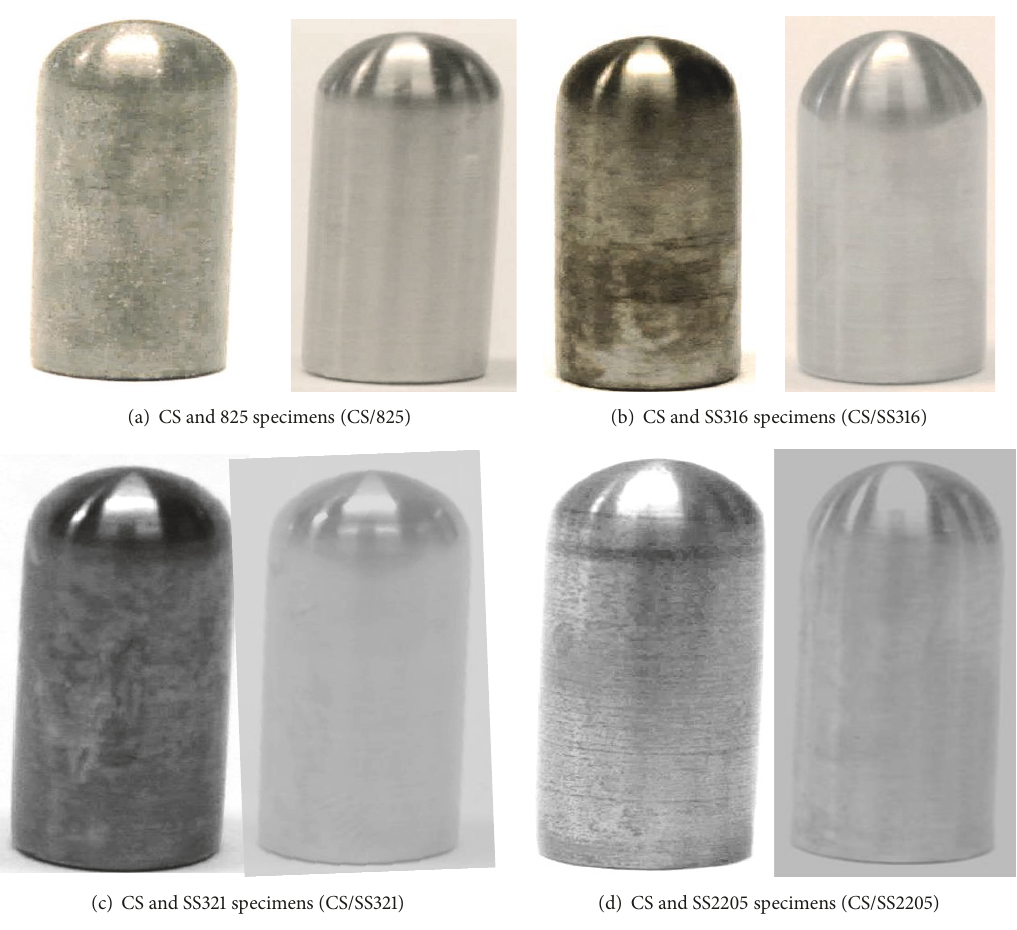
Figure 7: Cleaned, tested, and coupled alloys after testing in stagnant 3.5% ABS at 60 ∘